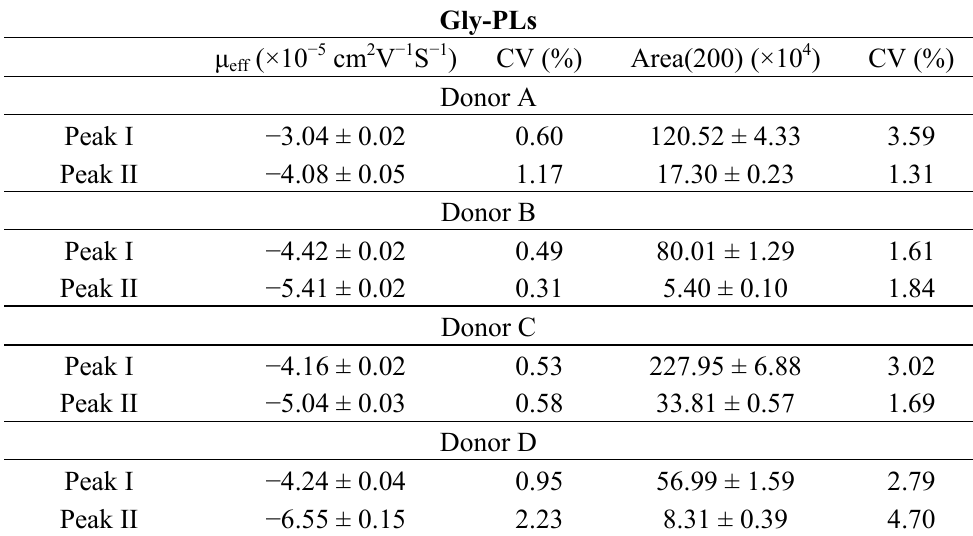
Table 7. The average effective mobility and peak area of in vitro glycated VLDL phospholipids analyzed by MEKC at absorbance 200 nm (data are means ± SD of four replicates).